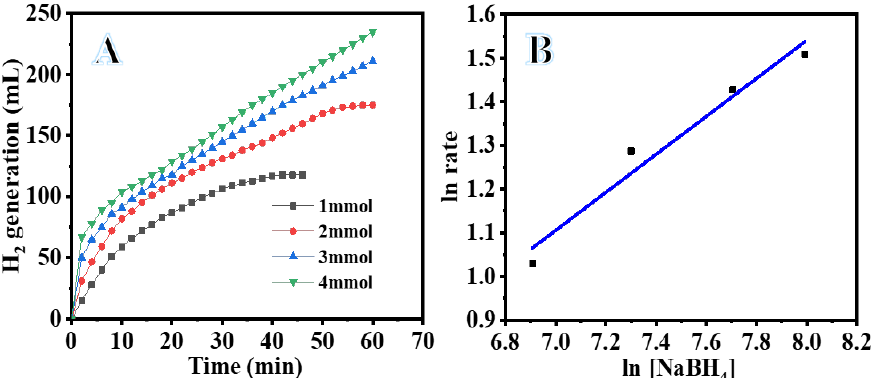
Figure 8. Effect of SBH concentration on H 2 generation ( A ) and the value of H 2 generation vs. value of [SBH] on logarithmic scale ( B ). The amount of Ni 75 Pd 25 @PVDF-HFP NFs membrane catalyst = 100 mg and T = 298 K.